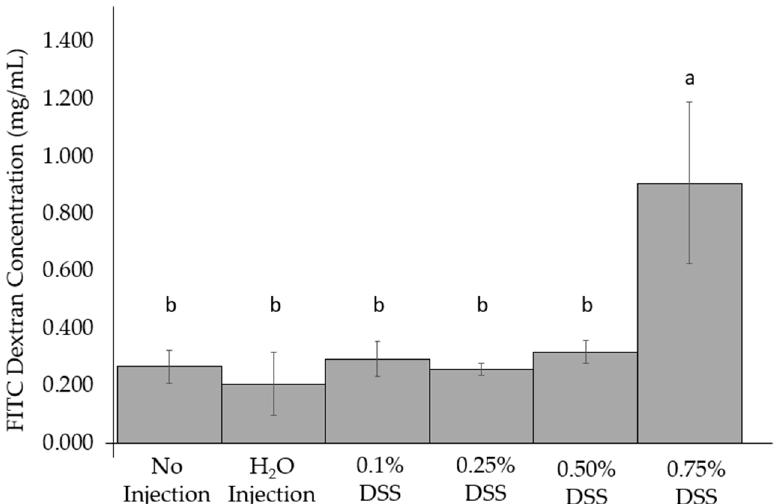
Figure 1. Comparison of the intra-amniotic administration of DSS to controls on the day of hatch within the small intestine (duodenum). Values are means ± stand error, n = 3. a,b within a column, means without a common letter are significantly different, p < 0.05 (Duncan’s post-hoc test).